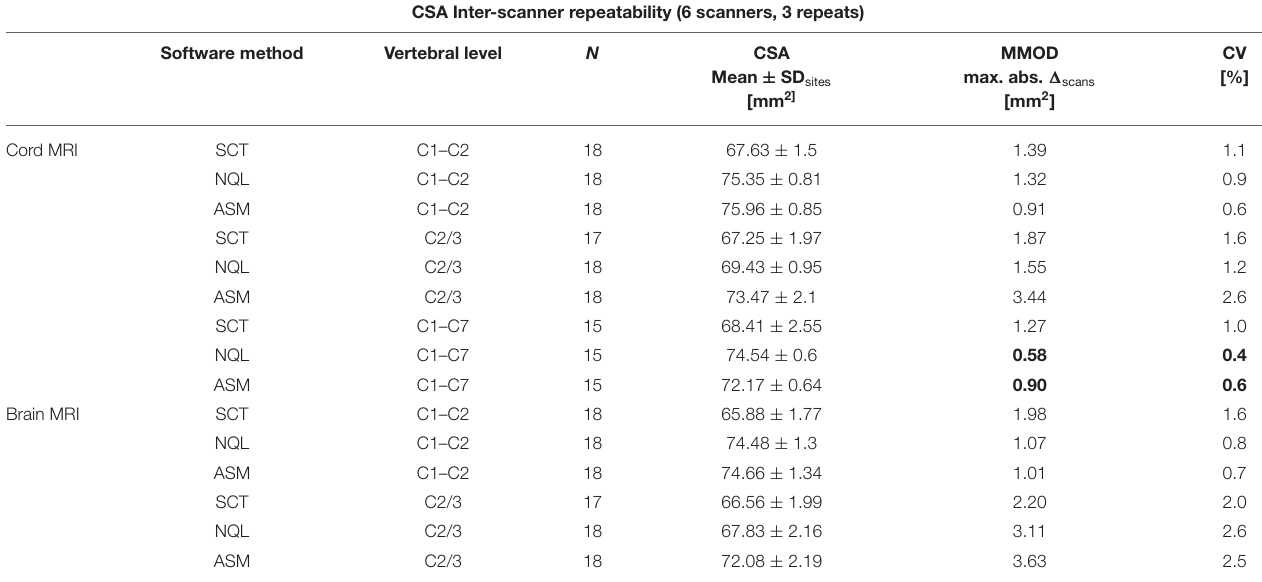
CSA mean SD averaged across all repetitions and all sites, avg. max. abs. 1 scans = ± CSA, cross-sectional area; MMOD, mean maximum observed difference; CV, coefficient of variation; SCT, Spinal Cord Toolbox; NQL, NeuroQLab; ASM, Active Surface